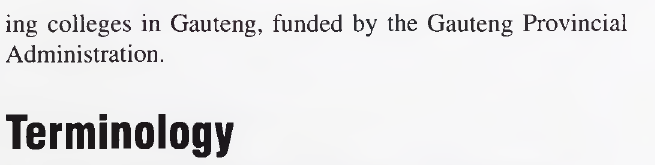
Table 2 : The planned